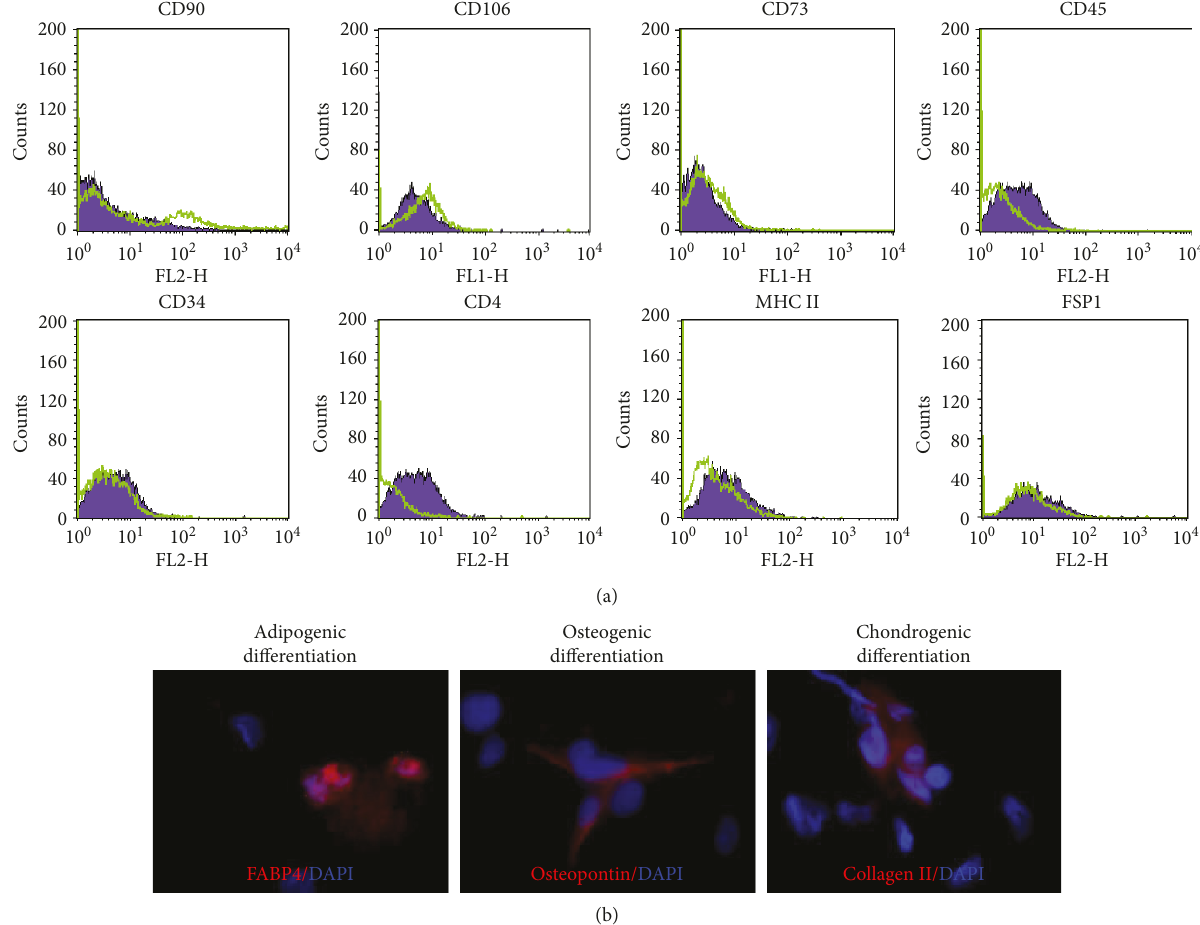
Figure 4: Phenotype characterization of ex vivo expanded cells. (a) Representative histograms of fl ow cytometry analysis show the expressions of CD90, CD106, CD73, CD45, CD34, CD4, MHC II, and FSP1 in the twice-passaged cells expanded from renal tissues at 7 days after ureteral obstruction. (b) Representative images of immuno fl uorescent staining on the adipogenic (FABP4-positive, red), ostogenenic (osteopontin-positive, red), and chondrogenic (collagen II-positive, red) di ff erentiations from the twice-passaged cells. Nuclei are counterstained with 4 ′ ,6-diamidino-2-phenylindole (DAPI,